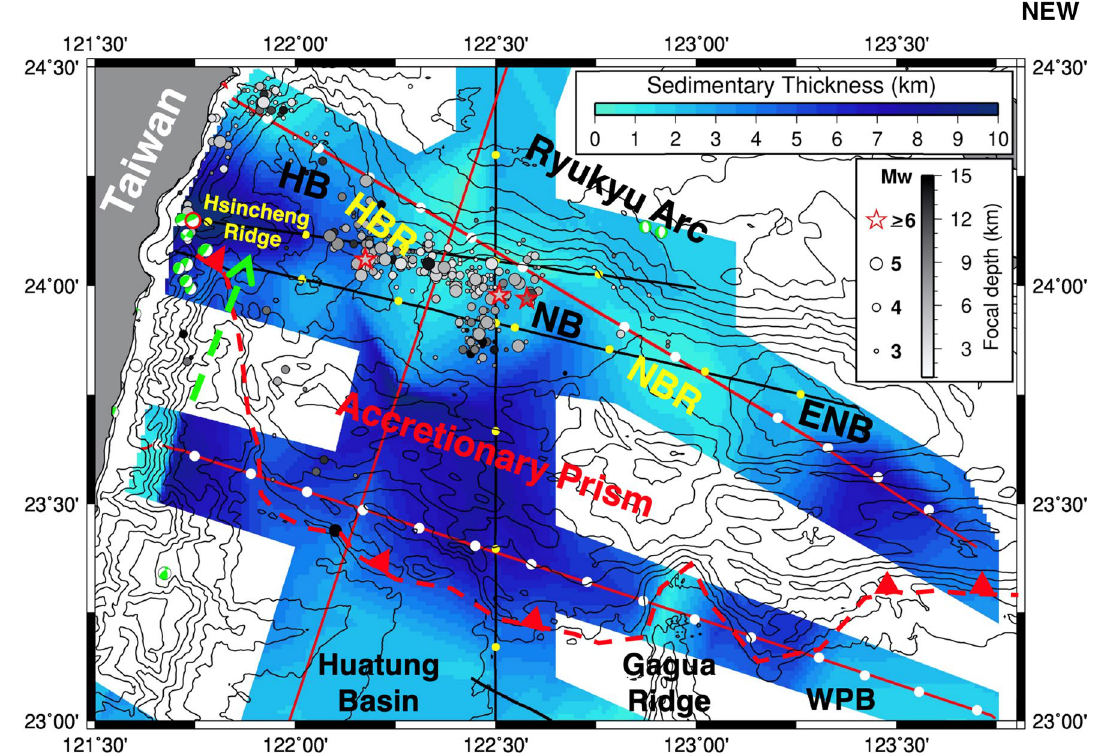
Fig. 11 The sedimentary thickness near the southernmost Ryukyu Trench superimposed by the relocated earthquakes at the depth of ≤ 15 km in 1992–1997 (Font et al. 2004). The red dashed line indicates the Ryukyu Trench with the red triangles which show the direction of subduction. The focal mechanisms of the earthquakes with the depth of ≤ 15 km are shown by the green (6 > Mw ≥ 5) beach balls. The green dashed‑line arrow shows the direction of the subducted PSP. The contour lines are bathymetry with the contour interval of 500 m. WPB: West Philippine Basin; HB: Hoping Basin; HBR: Hoping Basement Rise; NB: Nanao Basin; NBR: Nanao Basement Rise; ENB: East Nanao